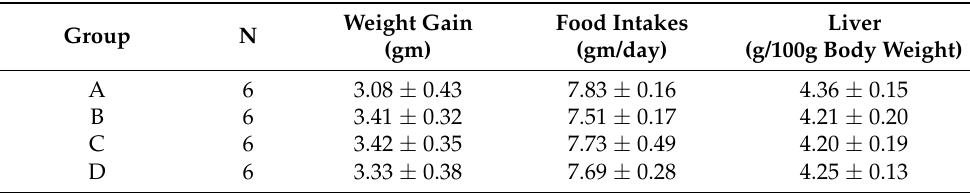
Table 1. Body weight gains, food intakes, and relative liver weight of 3-month-old male SAMP8 mice fed with different diet for 12